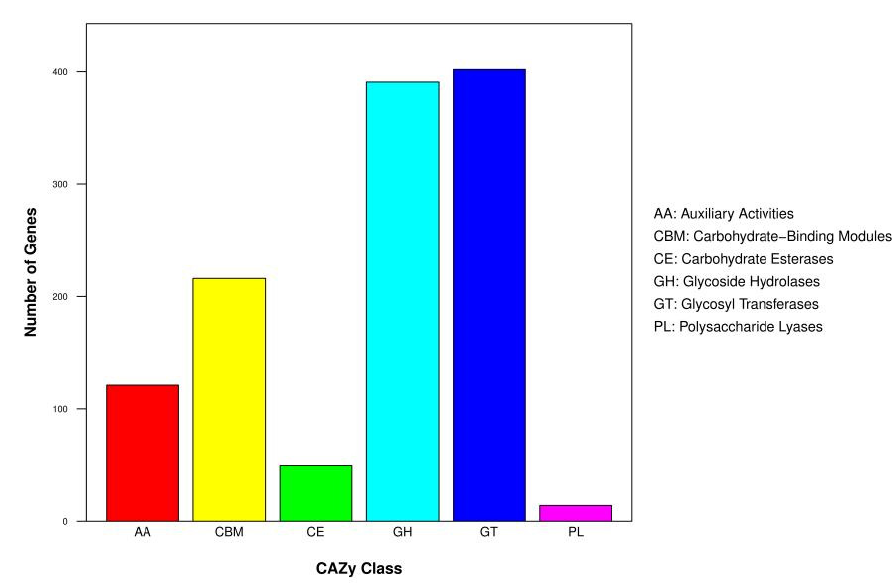
Figure 7. Distributions of CAZymes gene families in C. unicolor SP02 genome.